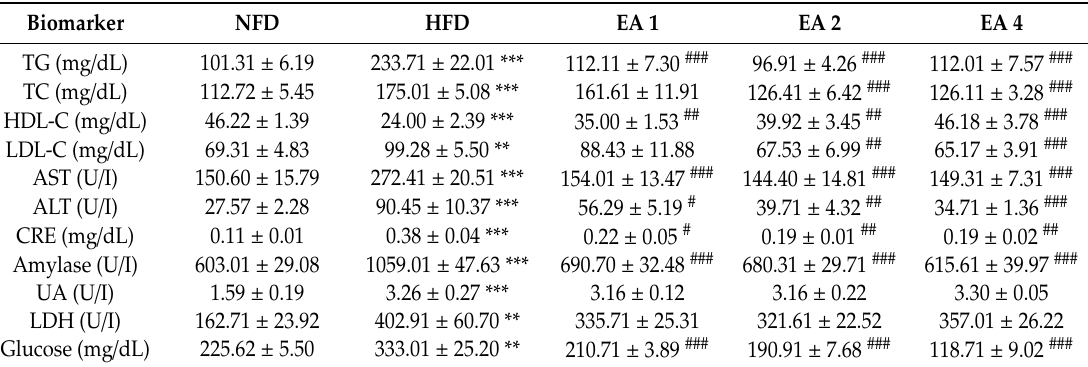
Table 2. E ff ect of ellagic acid on blood biochemical parameters in HFD-fed mice.